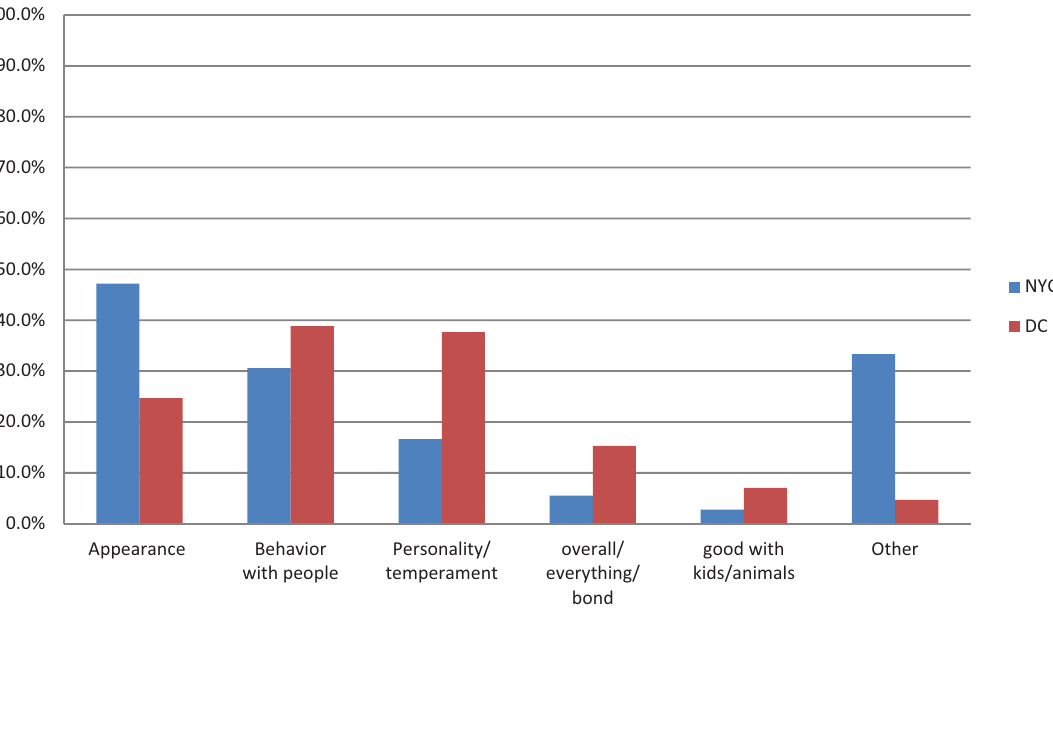
Figure 1. Comparison of dog characteristics that influence owner selection in New York City and Washington,